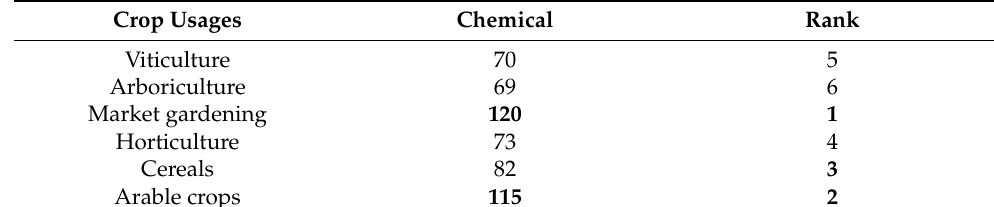
Table 2. Crop usages of the chemicals.